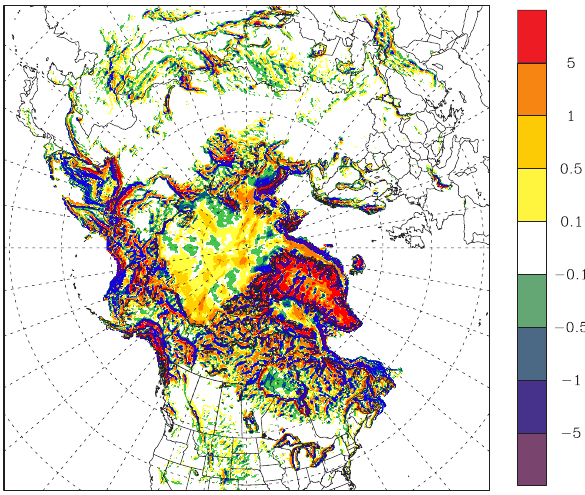
Fig. 7. Winter season divergence of blowing snow transport from the coupled model over DJF 2006/2007. Units in mm SWE.